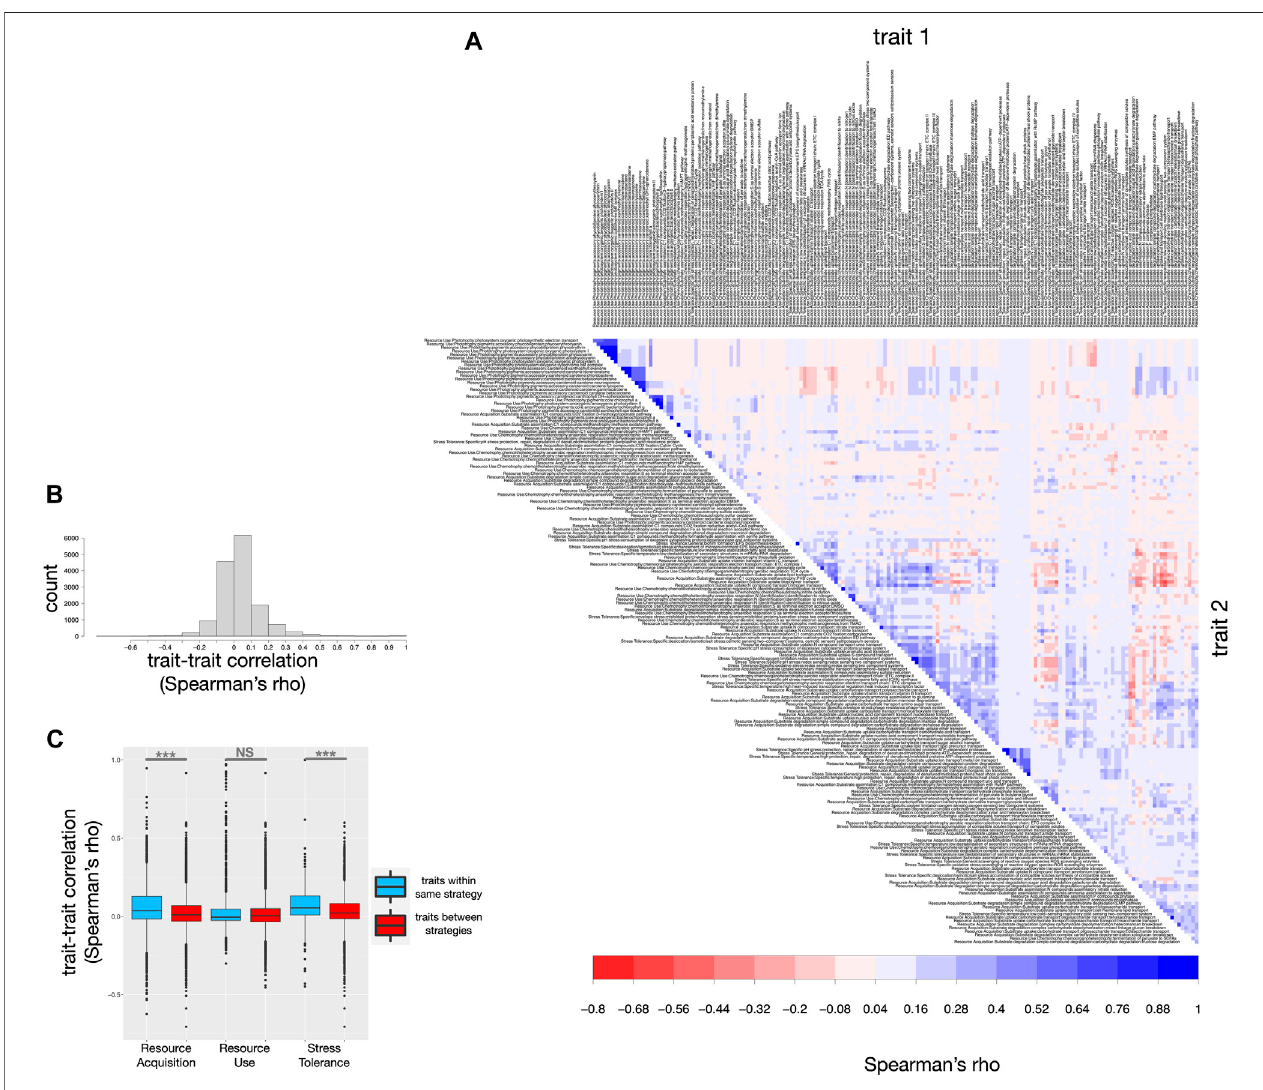
FIGURE 4 | Correlation matrix for microTrait de fi ned traits. The strength of the correlation (Spearman ’ s rho) is represented by the color intensity (positive: blue, negative: red). Left upper panel: the distribution of trait-to-trait correlation values, left lower panel: comparison of the distribution of trait-to-trait correlations within and between ecological